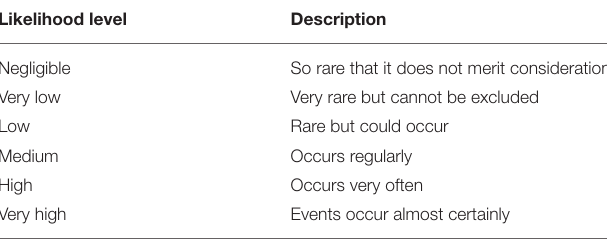
TABLE 1 | Definition of qualitative likelihood estimate